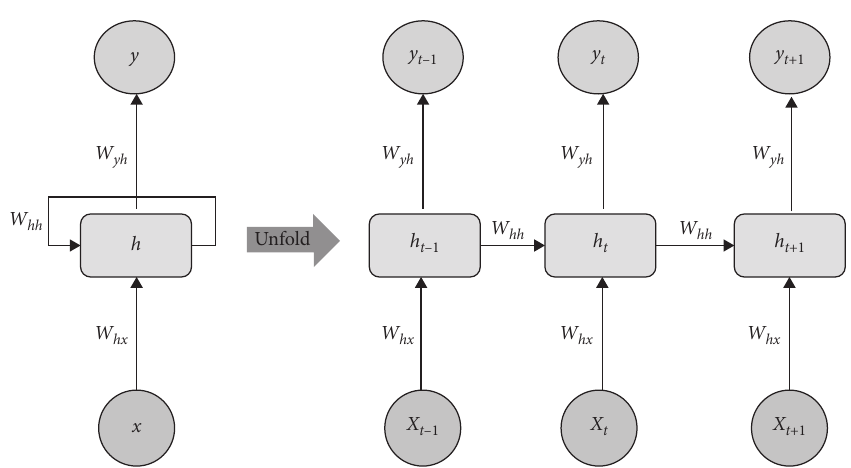
Figure 2: The expanded diagram of the basic structure of the